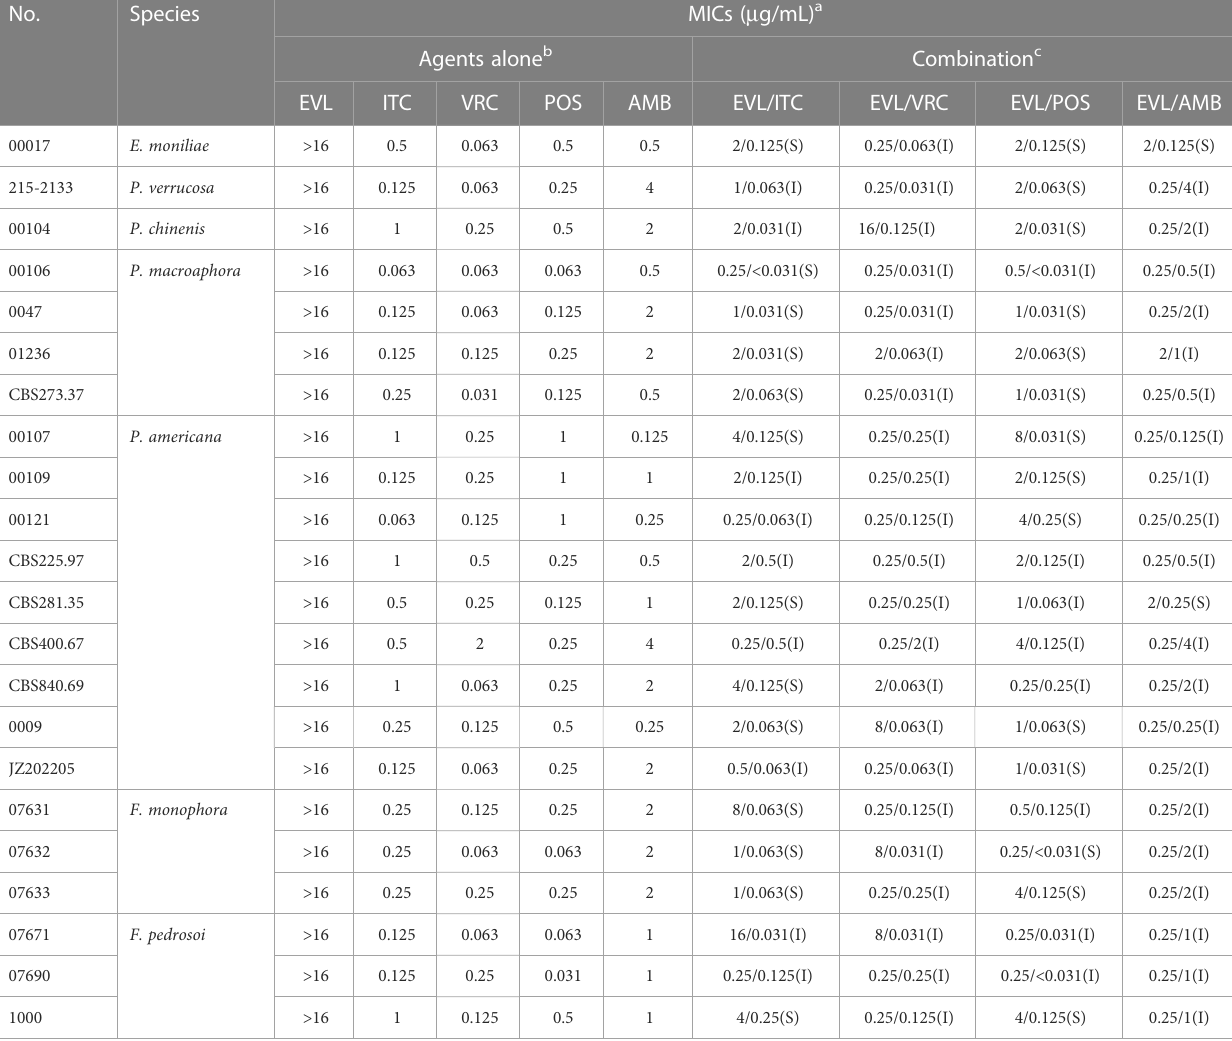
TABLE 1 Combination activity of EVL and antifungal drugs against dematiaceous fungi